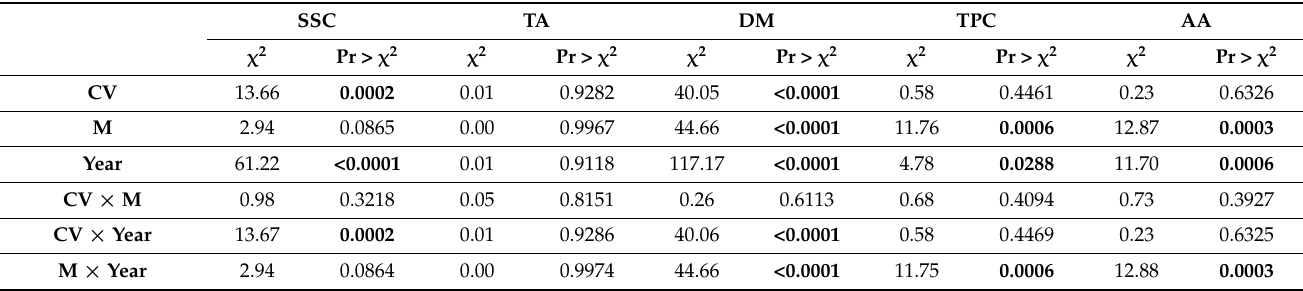
Table 4. χ 2 values and significance levels from GzLM regression for soluble solids content (SSC), titratable acidity (TA), dry matter (DM), total phenolic content (TPC), and antioxidant activity (AA).